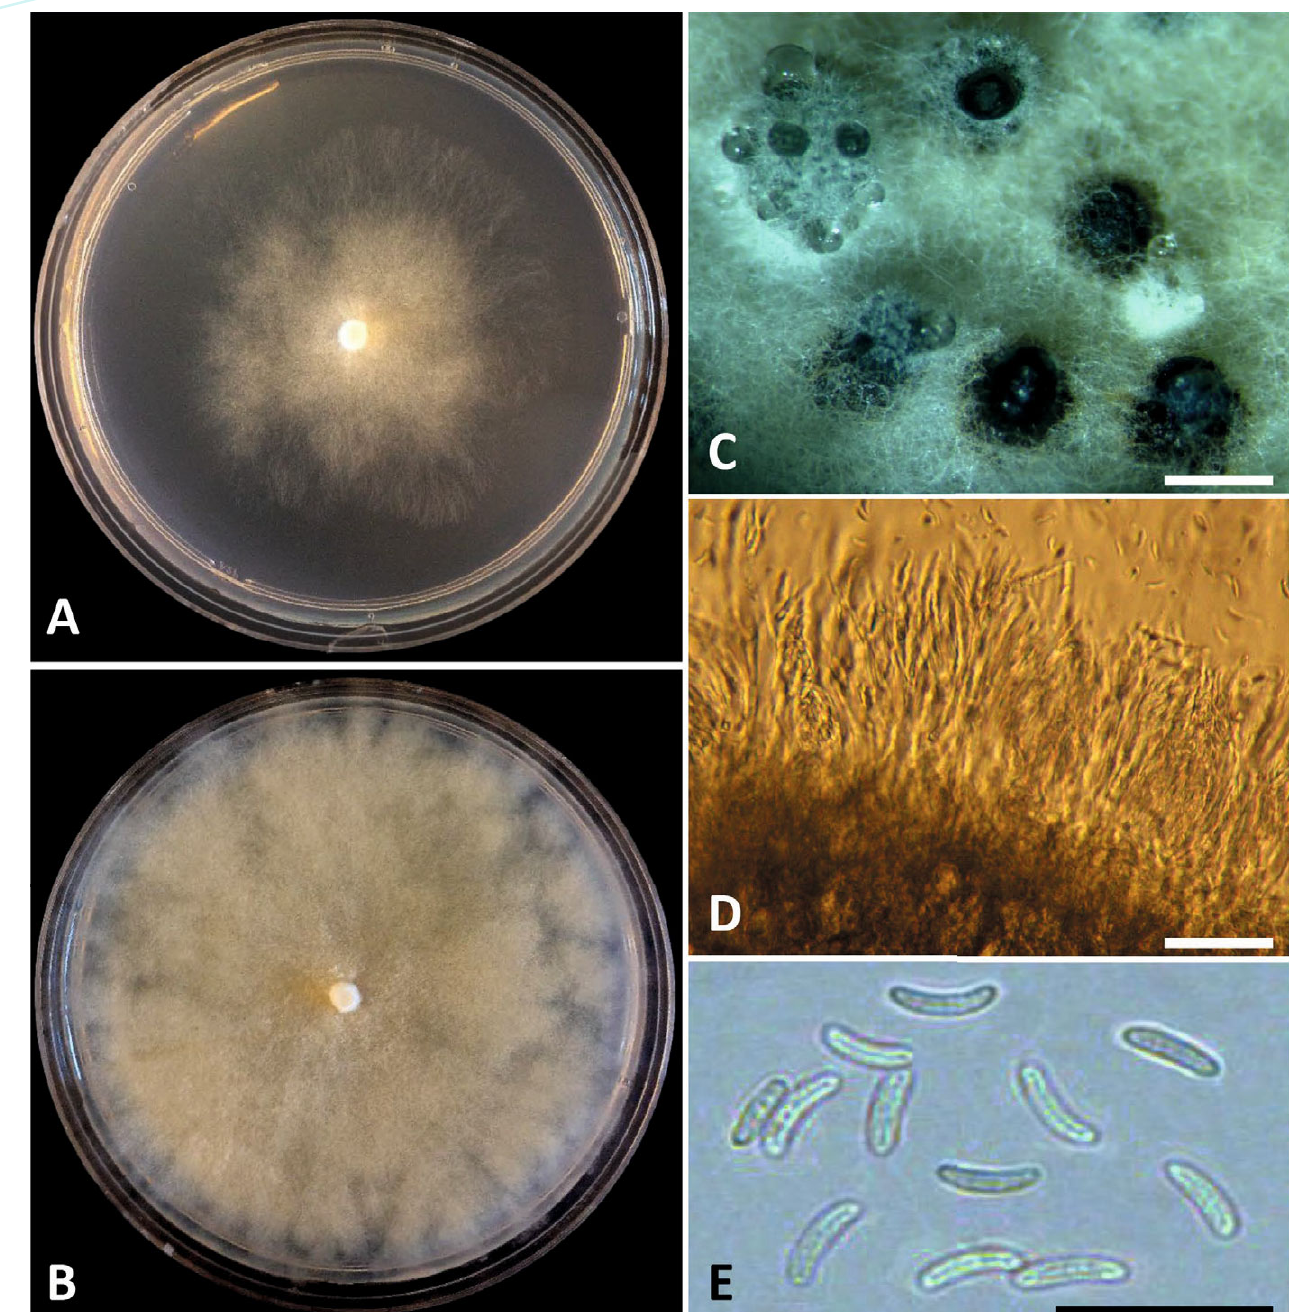
Fig. 12. Cytospora oleicola (ex-holotype culture CBS 144248). A. Seven-day-old PDA culture. B. Fourteen-day-old PDA culture. C. Pycnidia. D. {(cid:4)(cid:17)(cid:11)(cid:21)(cid:11)(cid:4)(cid:18)(cid:14)(cid:4)(cid:10)(cid:13)(cid:7)(cid:2)(cid:9)(cid:17)(cid:21)(cid:2)(cid:20)(cid:23)(cid:9)(cid:6)(cid:13)(cid:17)(cid:8)(cid:4)(cid:5)(cid:7)(cid:2)(cid:19)(cid:4)(cid:17)(cid:11)(cid:21)(cid:11)(cid:4)(cid:25)(cid:13)(cid:17)(cid:4)(cid:5)(cid:7)(cid:2)(cid:19)(cid:13)(cid:23)(cid:23)(cid:7)(cid:28)(cid:2) E. Conidia. Bars C = 500 μm; D = 20 μm; E = 10